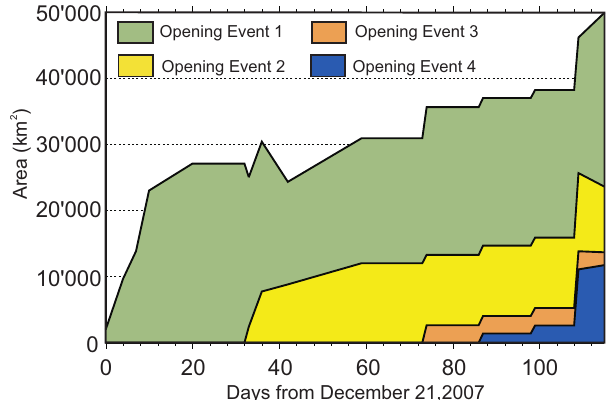
Fig. 4. Evolution of sea ice area in km 2 formed after polynya openings along the fast ice edge: Green – Event 1 (December), Yellow – Event 2 (January), Orange – Event 3 (March), Blue – Event 4 (April).